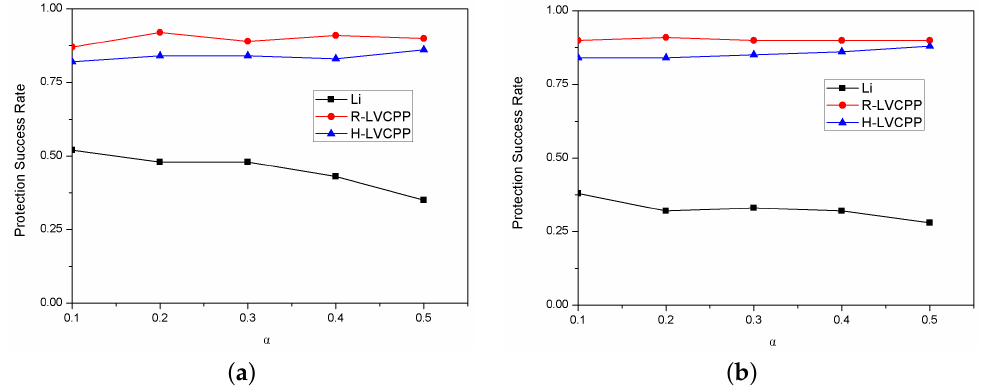
Figure 8. Protection success rate evaluation under different α : ( a ) Brightkite; ( b ) Gowalla.